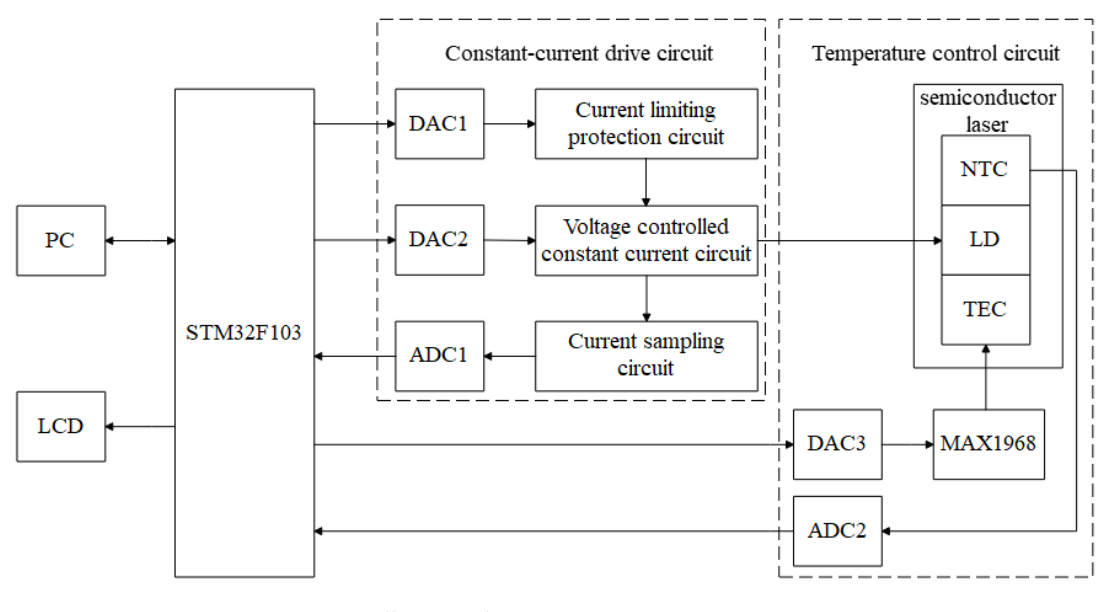
Figure 3. Overall system design.